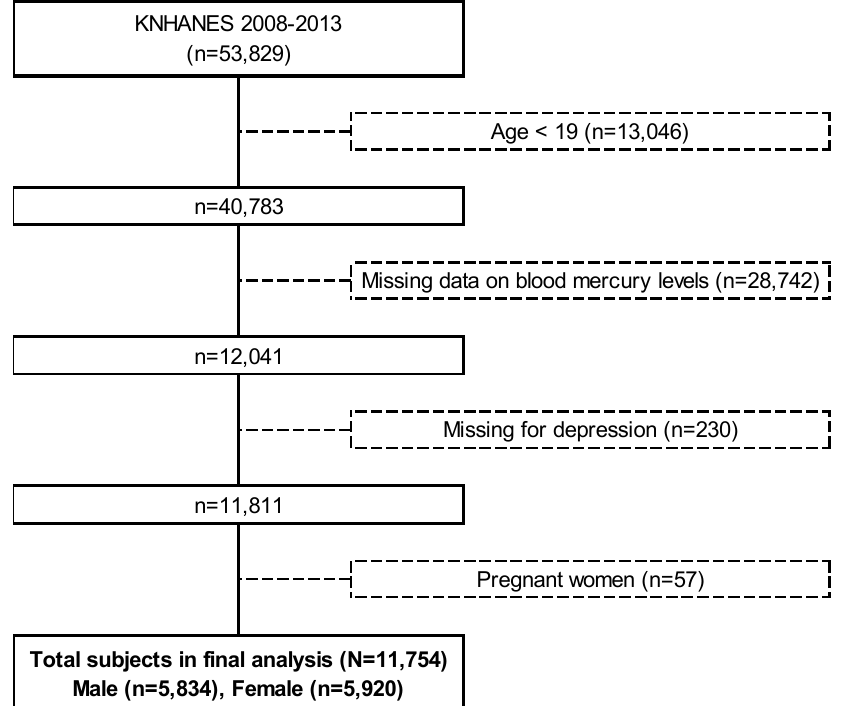
Figure 1. Flow diagram of selection of participants for inclusion in the present study (KNHANES 2008– 2013).